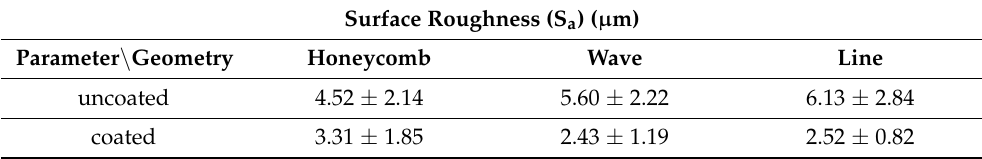
Table 6. Comparison of surface roughness of uncoated vs coated PCL, with variations in geometry, n =